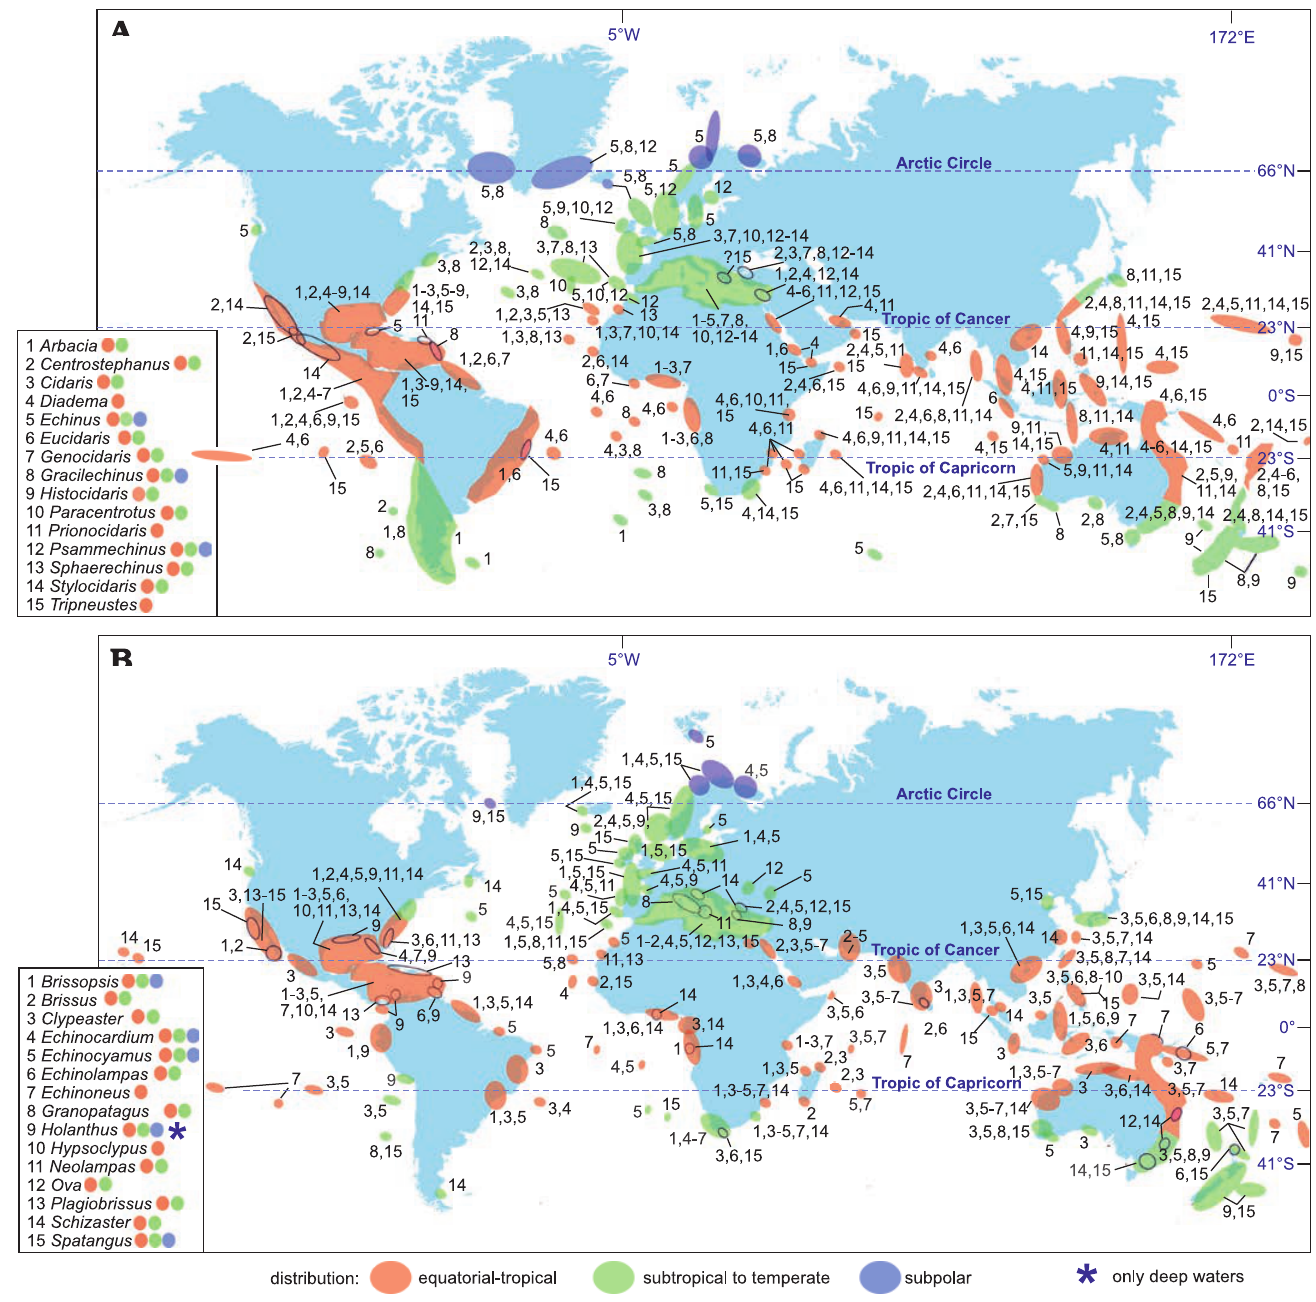
Fig. 3. Biogeography of regular ( A ) and irregular ( B ) echinoid genera which occurred in the Mediterranean during the Late